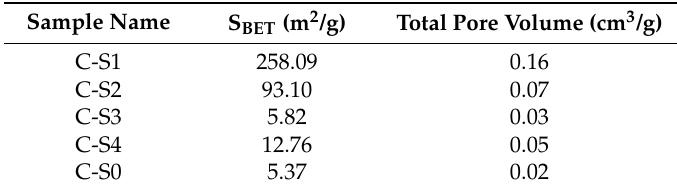
0.080 0.081 0.082 0.083 0.084 0.085 0.086